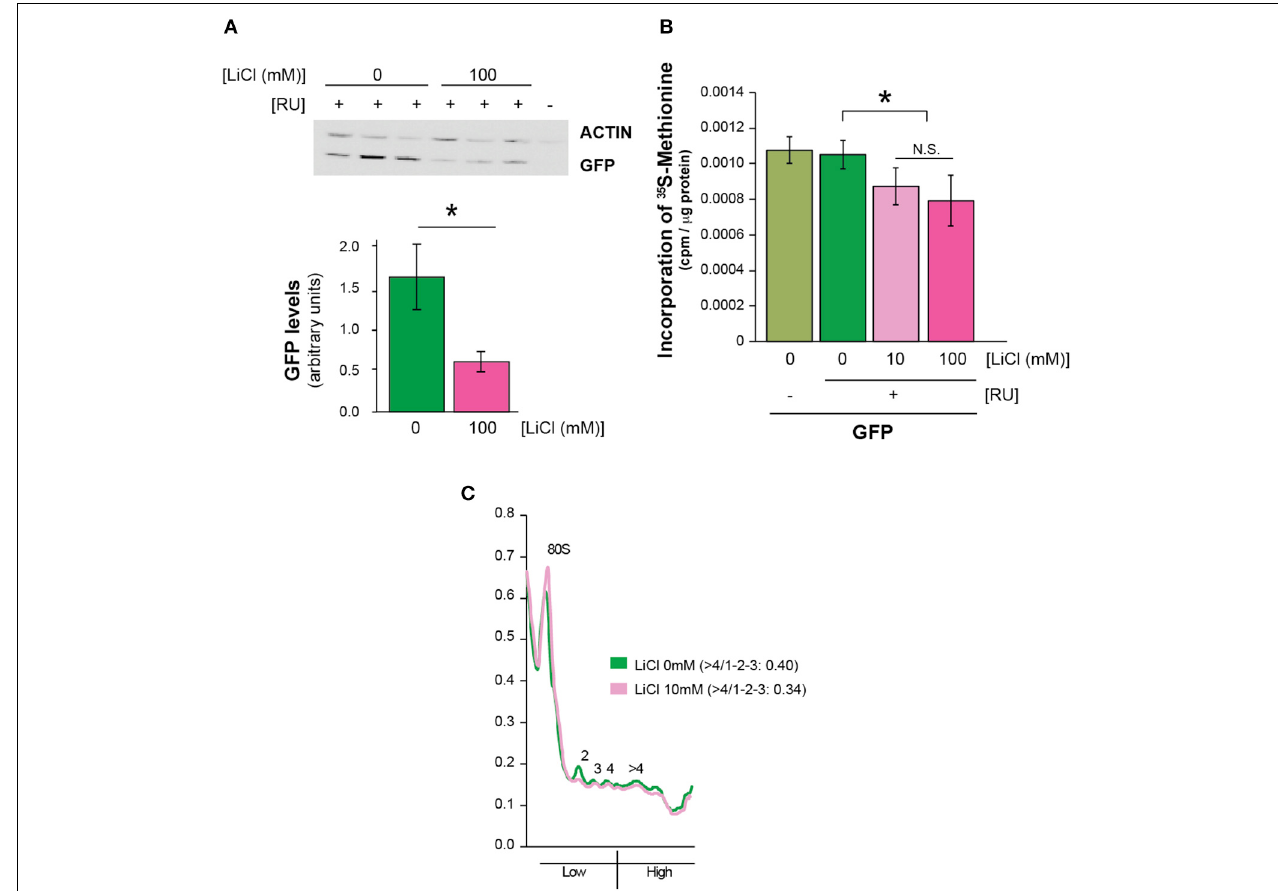
FIGURE 2 | Lithium reduced overall protein synthesis/translation. (A) Protein levels of UAS-egfp/ + ;elavGS/ + flies on + RU486 SY medium, and UAS-egfp/ + ;elavGS/ + flies on + RU + 100mM LiCl were measured by Western blot analyses at 7 days post-induction (see Materials and Methods). GFP levels were significantly reduced when comparing UAS-egfp/ + ;elavGS/ + + RU to UAS-egfp/ + ;elavGS/ + + RU + LiCl 100mM, ∗ P < 0 . 001. Data were compared using One-Way ANOVA, number of independent tests ( n ) = 6. (B) Protein synthesis was reduced in pooled UAS-egfp/ + ;elavGS/ + + RU + LiCl